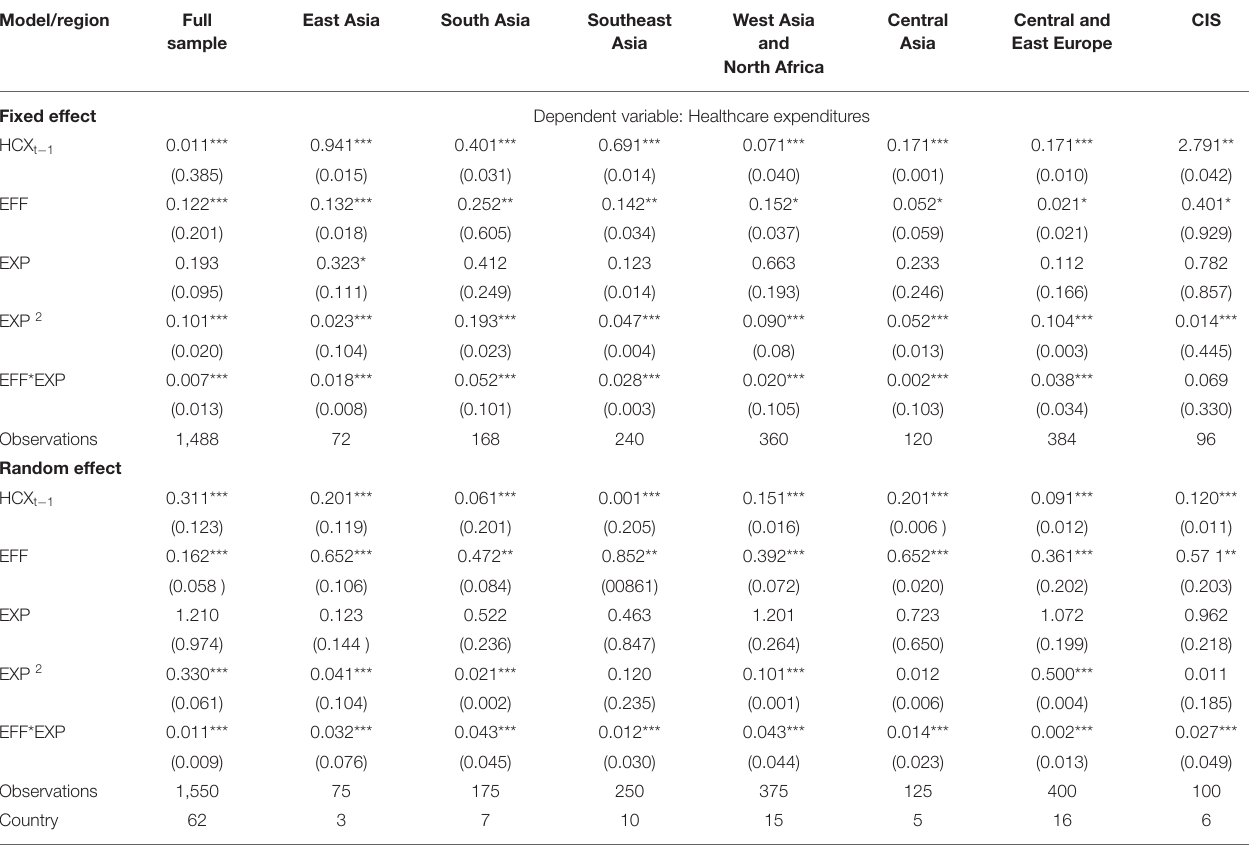
TABLE 8 | Regional analysis of BRI (healthcare expenditure